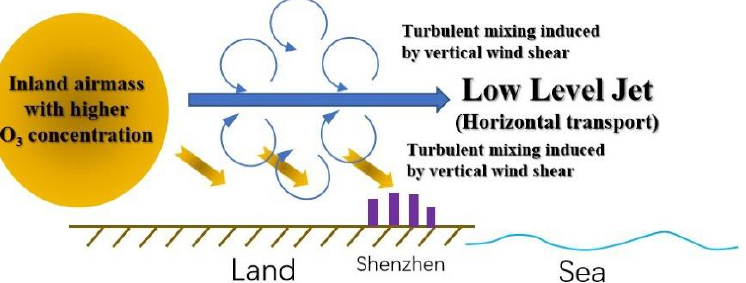
Figure 8. Conceptual model of nocturnal O 3 pollution under the land breeze over Shenzhen.